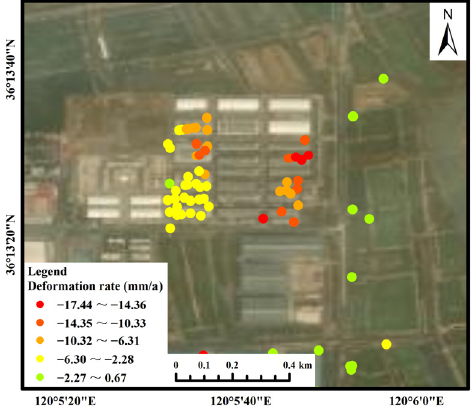
Figure 13. Deformation rate of a logistics company in Area B.